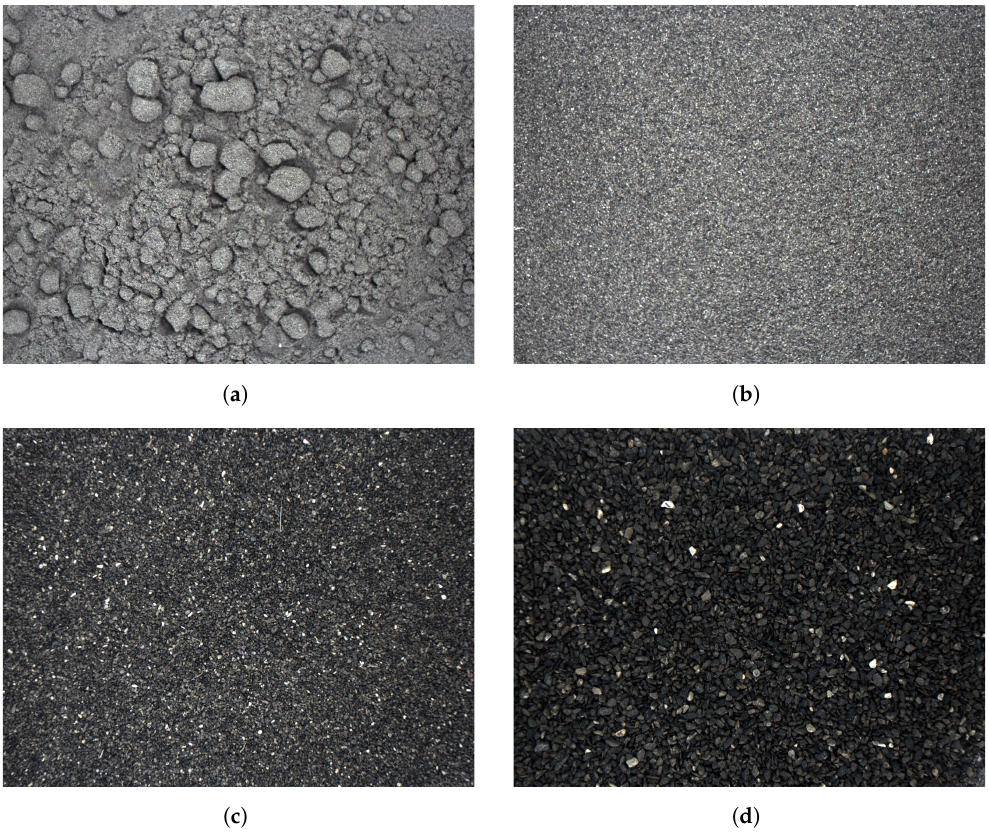
Figure 18. Copper ore samples of 3% moisture, with particle sizes of: ( a ) less than 0.1 mm; ( b ) 0.1– 0.2 mm; ( c ) 0.2–0.5 mm; ( d ) 0.5–1